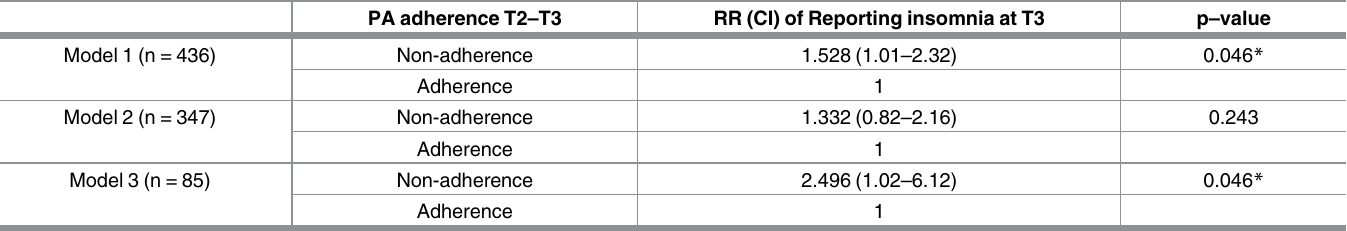
Table 5. The risk ratios of three models investigating the risk of reporting future insomnia among individuals with a LBP/NP risk profile. * = statisti- cal